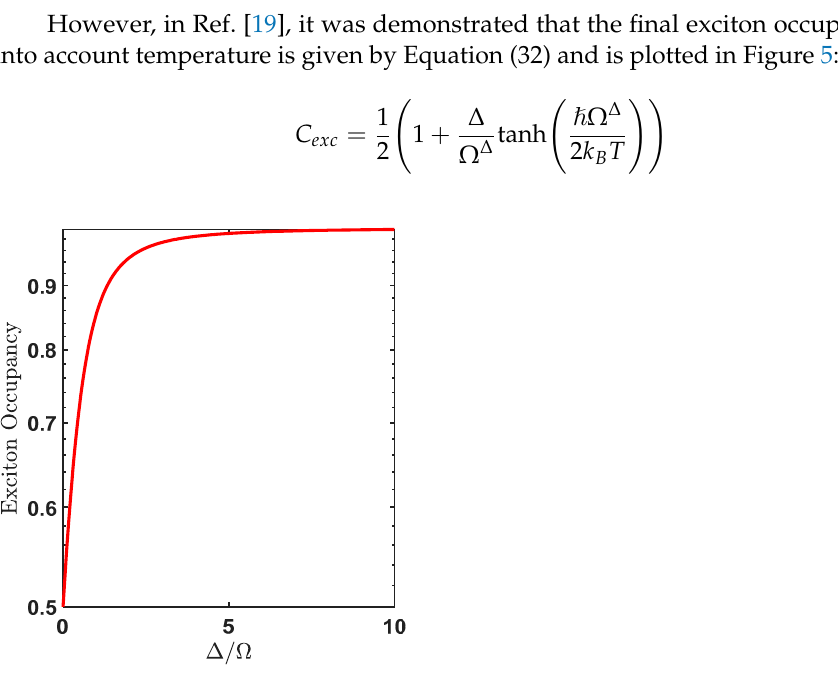
Figure 5. Exciton occupancy (using Equation (32)) in the final state at T = 1 K.